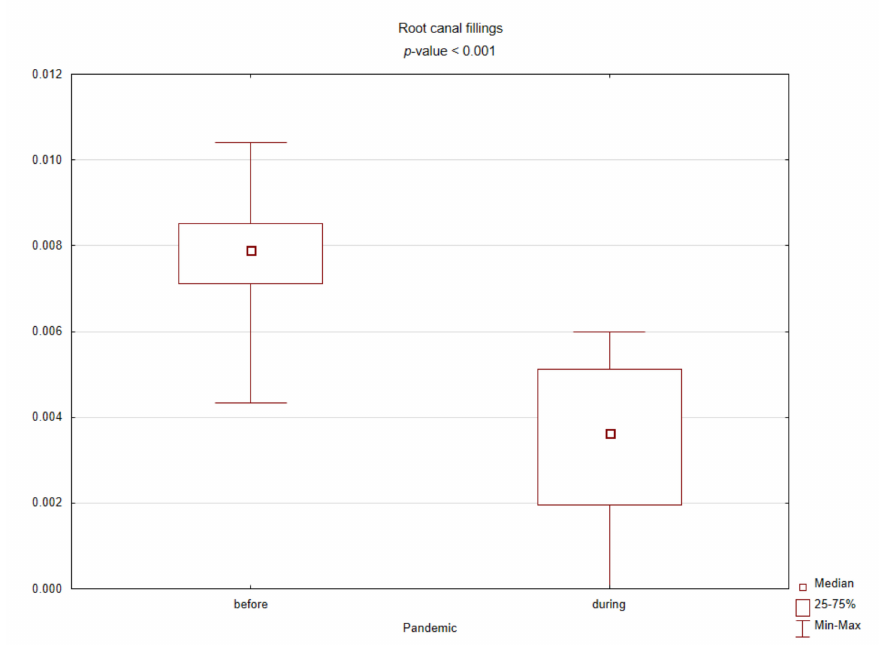
Figure 4. Box plot for the standardized number of root canal fillings before and during the COVID-19 pandemic ( p -value < 0.05 according to the Mann–Whitney test).